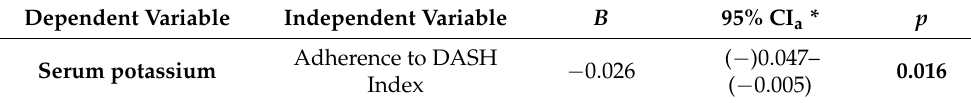
Table 3. Linear regression between serum potassium and adherence to the DASH